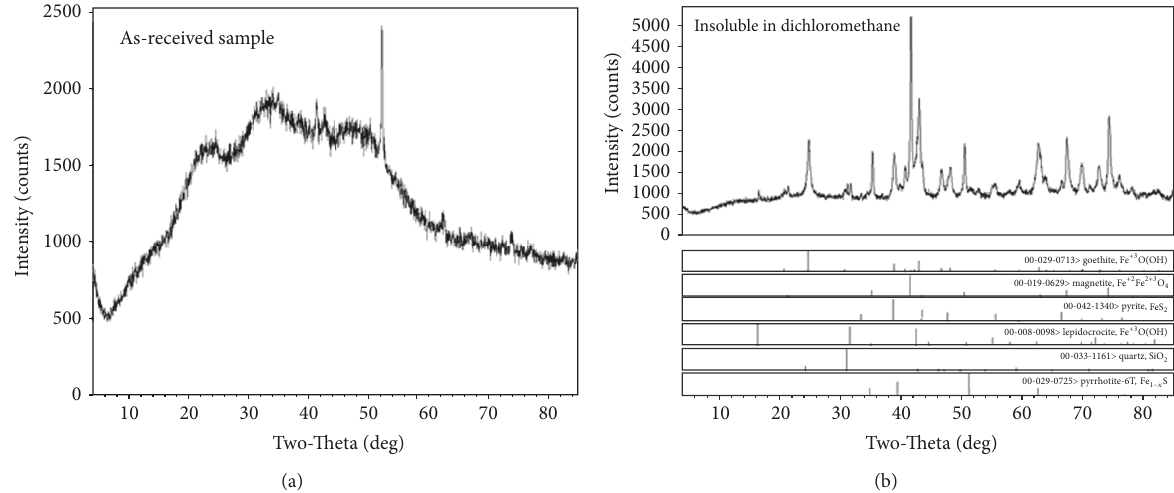
Figure 4: XRD data of the sludge sample: (a) as-received (i.e., mix between the amorphous with the small addition of crystalline materials) and (b) after removing the hydrocarbon (i.e., inorganic materials).